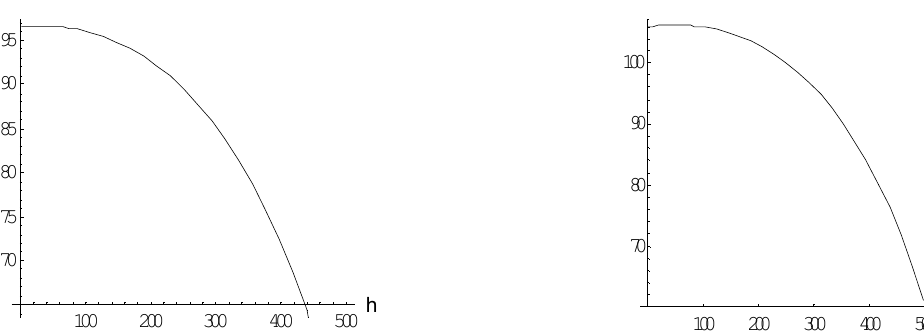
Fig 7.(a) The effect of parameter η on the total cost in the crisp model